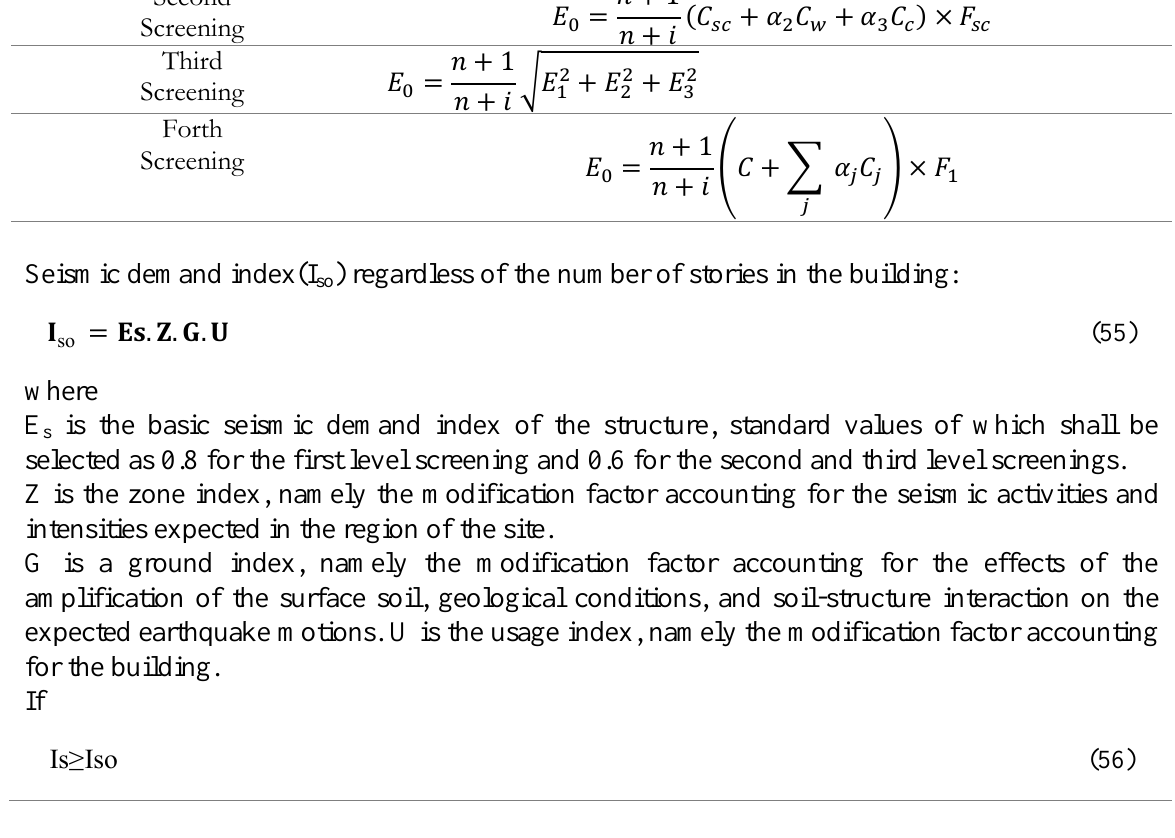
Table 6. Values of the primary seismic index(E